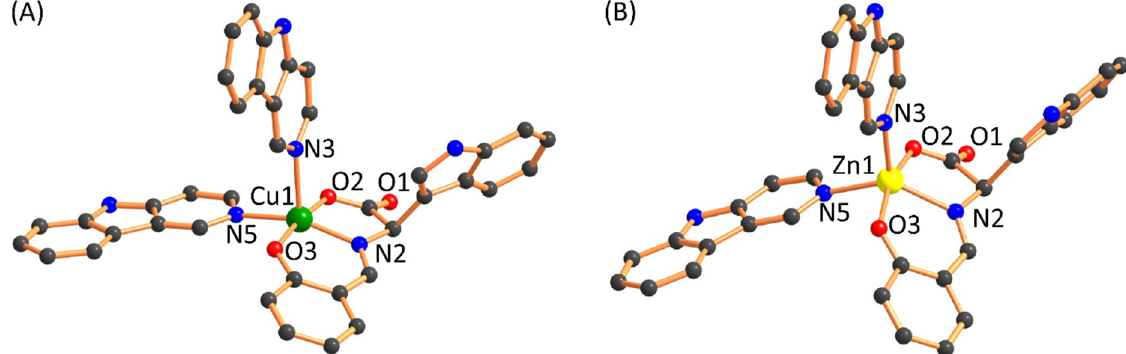
Figure 2. DFT optimized structures of complex ( A ) 1 and ( B ) 2 . Only coordinated donor atoms are labeled. Hydrogen atoms are omitted for clarity. Table 1. Selected bond distances (Å) for complexes 1 and 2 .